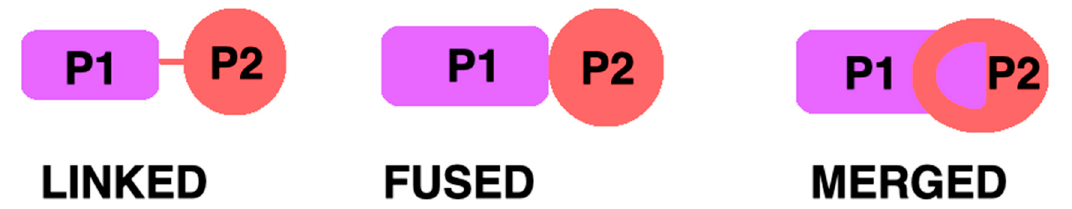
Figure 3. Classification of hybrid ligands (chimeras) based on pharmacophore (P) linking.